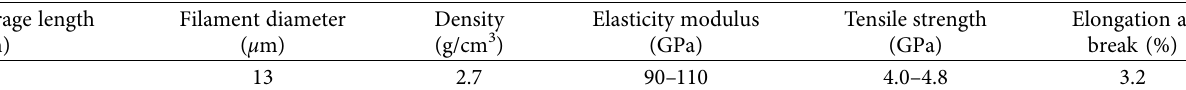
Table 2: Physical and mechanical properties of basalt